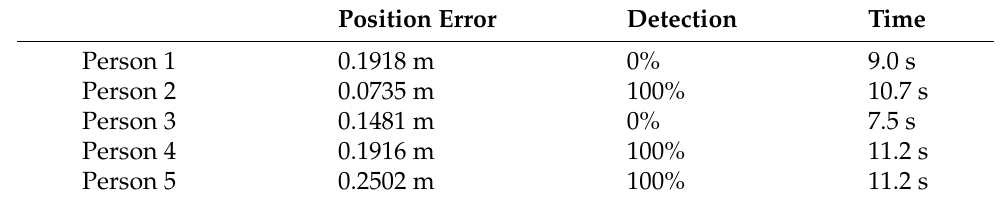
Table 1. People Perception FBM results for 5 People.